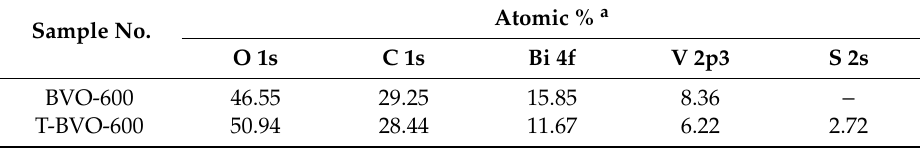
Figure 3. Scanning electron microscopy (SEM) images the BiVO 4 samples: T-BVO-600 ( A ) and BVO-600 ( B ) and field emission scanning electron microscopes and energy-dispersive X-ray spectrometer (FESEM/EDS) images of the T-BVO-600 sample with maps of Bi Ma1, V Ka1, OKa1, and S Ka1 ( C ). Table 2. Surface element compositions of the BVO-600 and T-BVO-600 samples. Sample